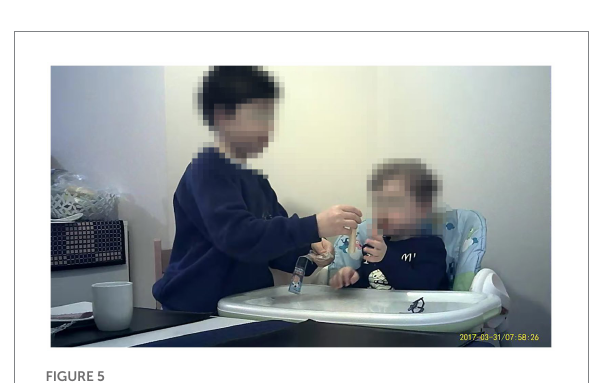
FIGURE 5 Helping others